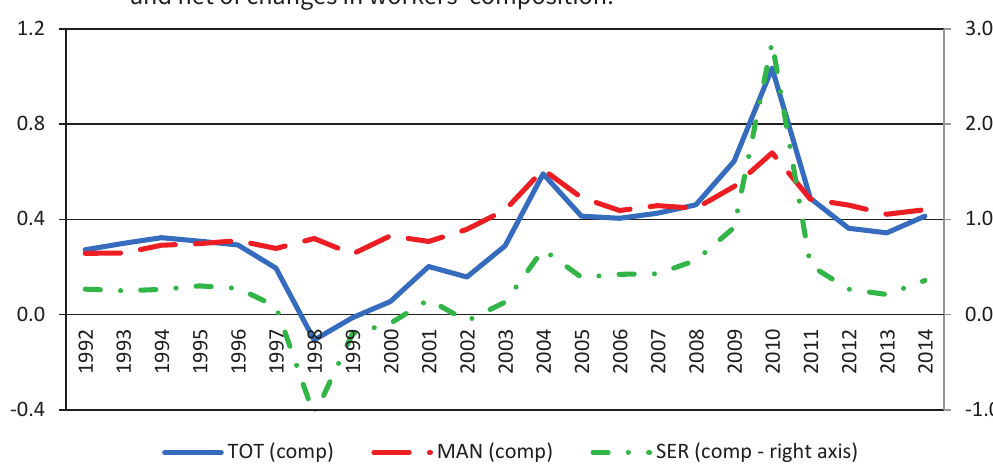
( ) ∆ ∆ w OP / tm tm , by sector